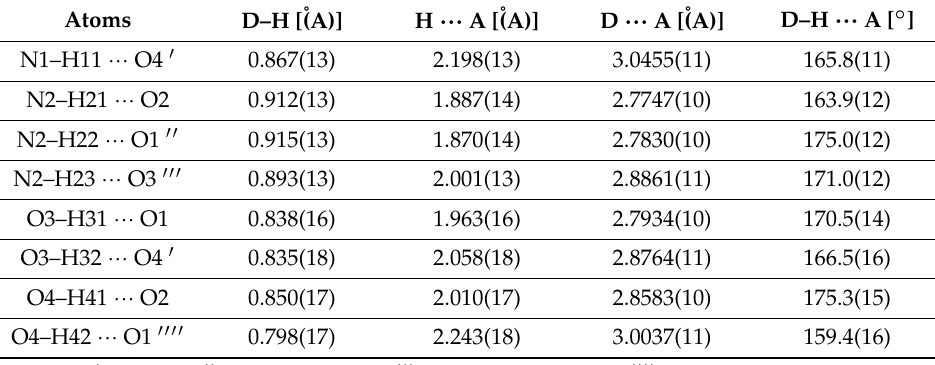
Figure 1. Displacement ellipsoid plot of the asymmetric unit of the title structure (3-ammonio-2,2-dimethylpropyl)carbamate dihydrate. Ellipsoids are shown at the 50% probability level. Dashed blue lines represent hydrogen bonds (cf. Table 2). Table 2. Geometric parameters of classical hydrogen bonds in the title structure.